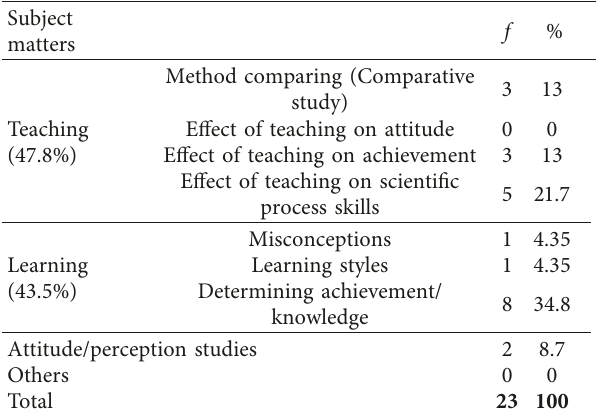
Table 5: General subject areas in the IBL studies in Ethiopia (2010 to